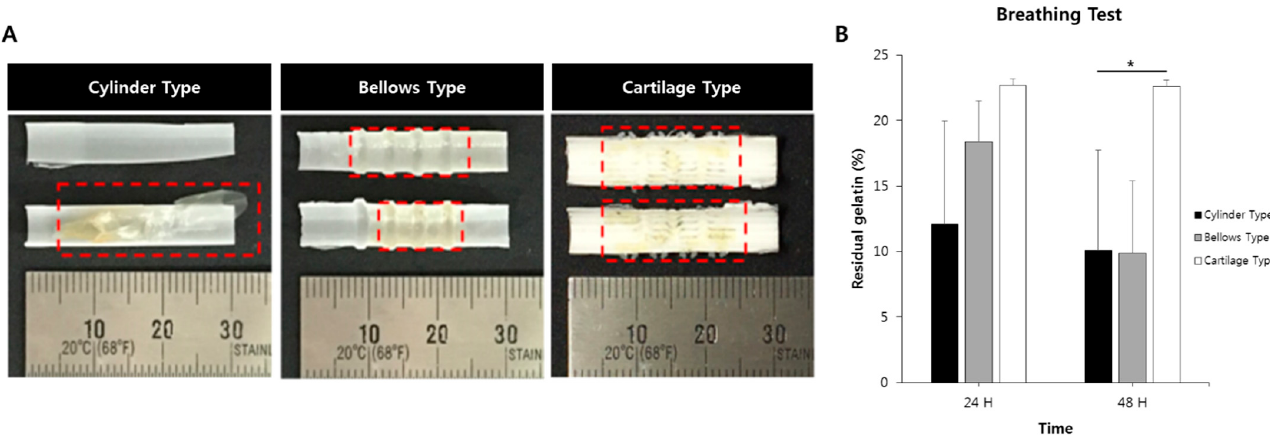
Figure 12. Measurement of residual hydrogel after the breathing test. ( A ) Observation of the luminal side after the breathing test and ( B ) gelatin residual after the breathing test. (* p < 0.05).